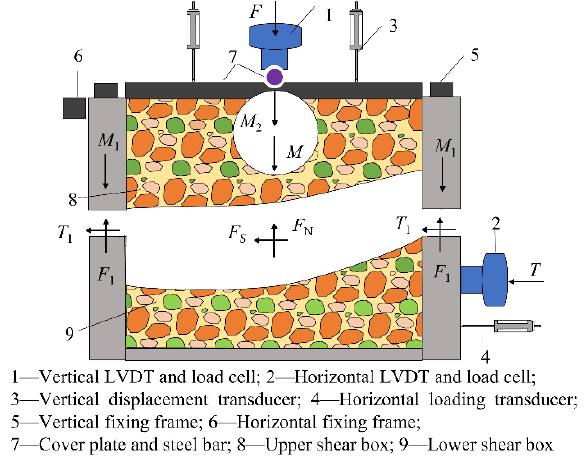
Figure 2. Structure diagram and loading mode of the large-scale direct shear apparatus (Shear Trac Ⅲ ).